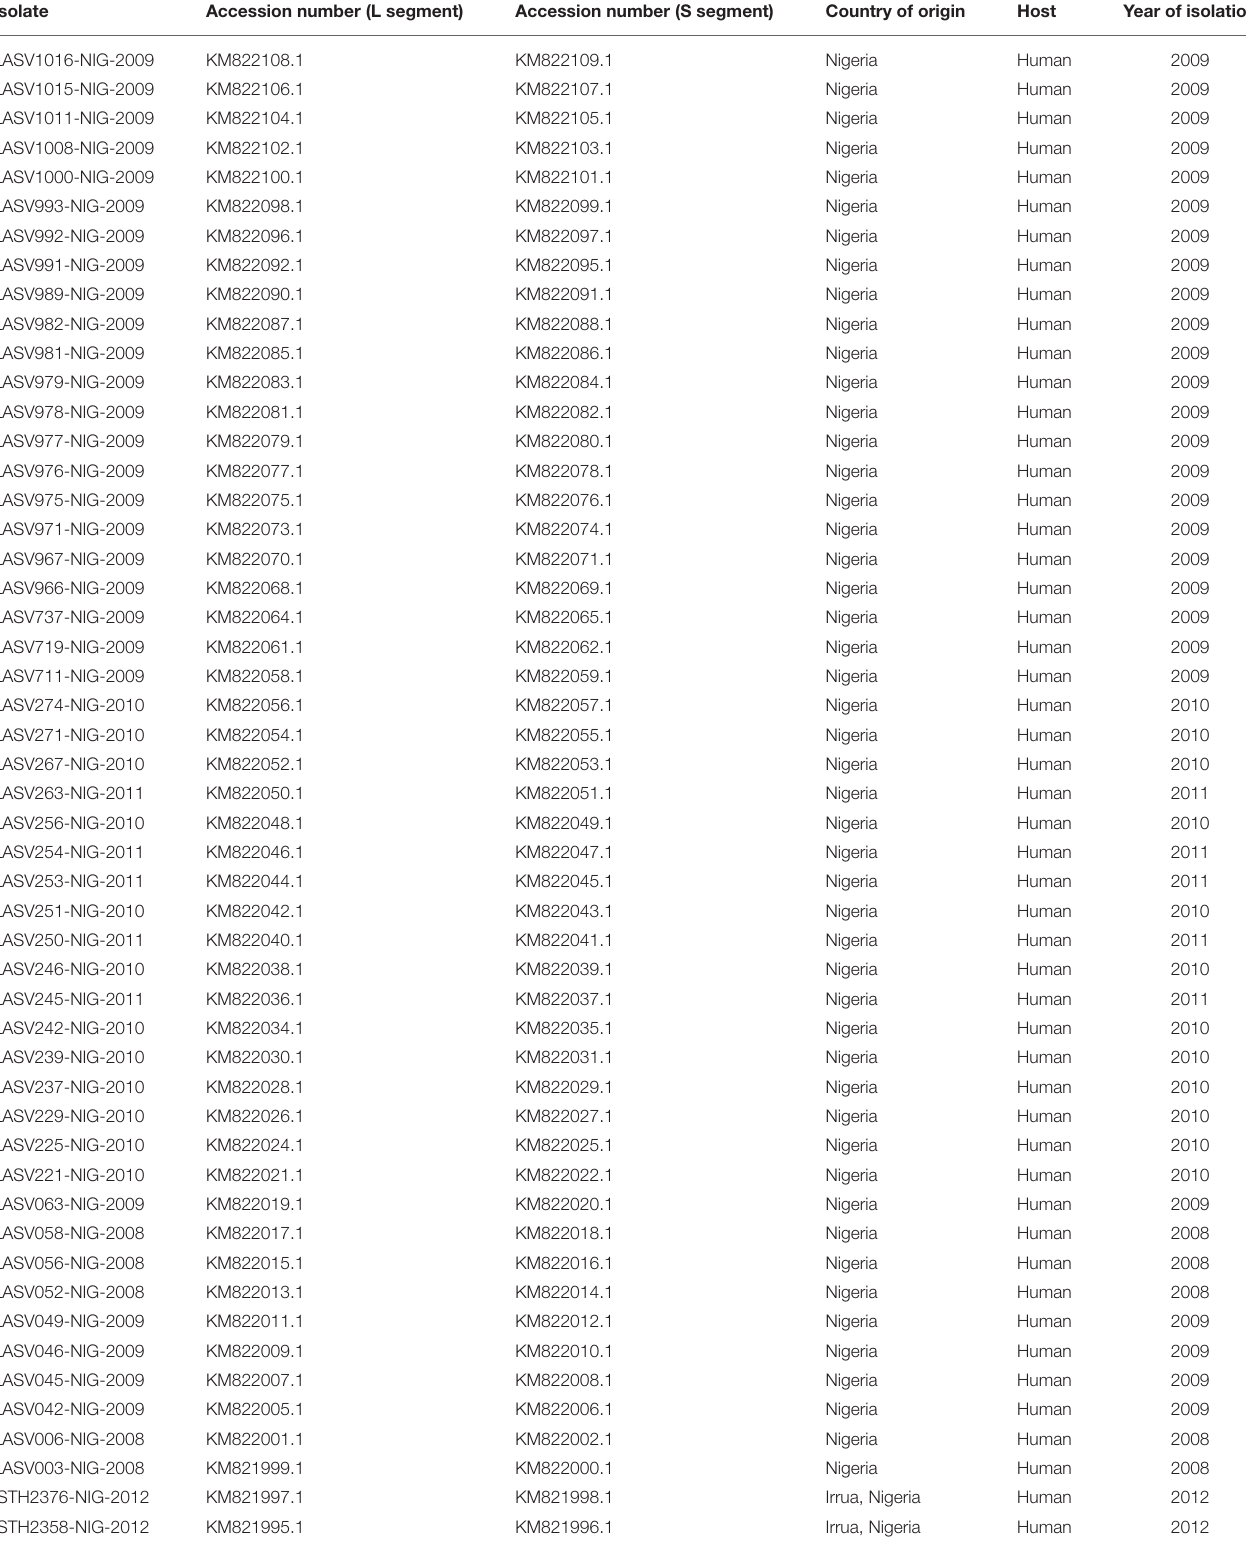
TABLE 1 | Demographic information for each LASV isolate used in the analysis.